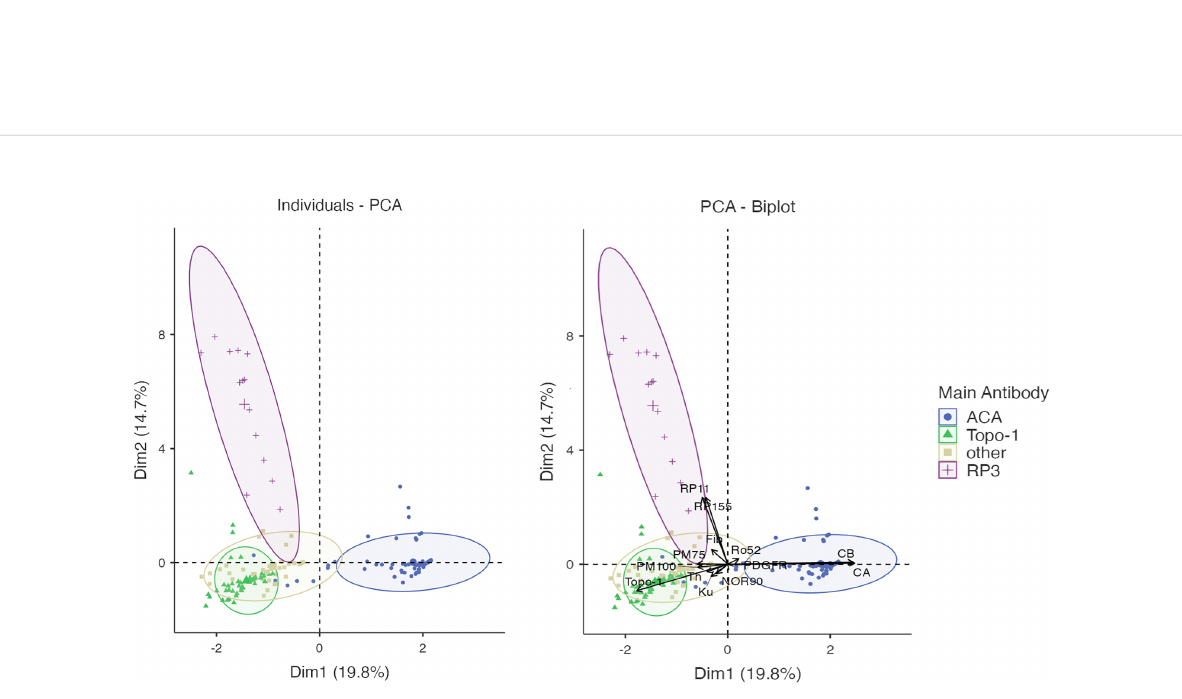
FIGURE 2 Clustering by K-means method revealed 4 autoantibody clusters: ACA, Topo-1, Others and